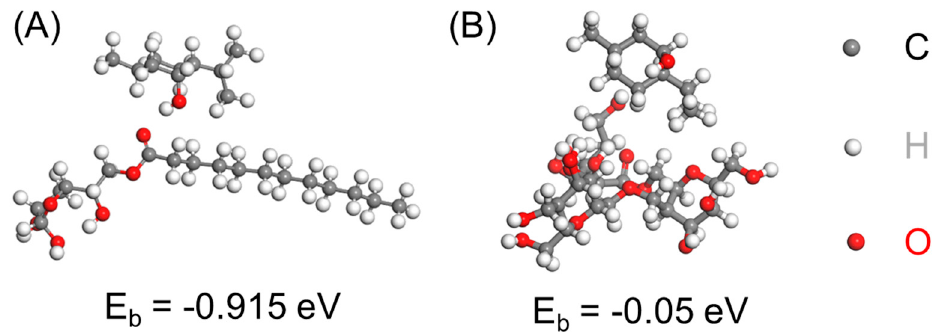
Figure 1. ( A ) Optimized configuration showing the adsorption of menthol on ( A ) sorbitan monostearate and on ( B ) a model polymer block mimicking guar.